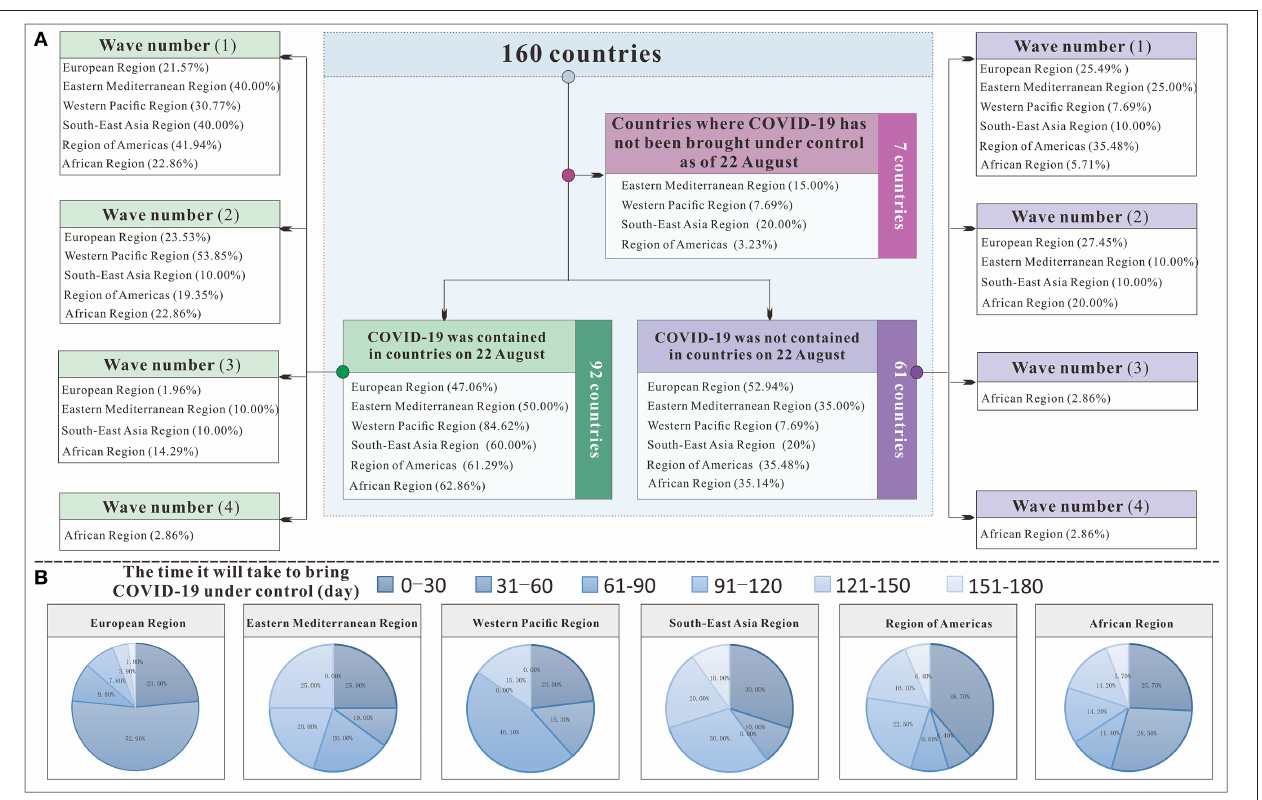
FIGURE 7 | The transmissibility and control effect classification flow chart to control COVID-19 in 160 countries. (A) shows the classification process of 160 countries; (B) shows the time each region needed to bring COVID-19 under